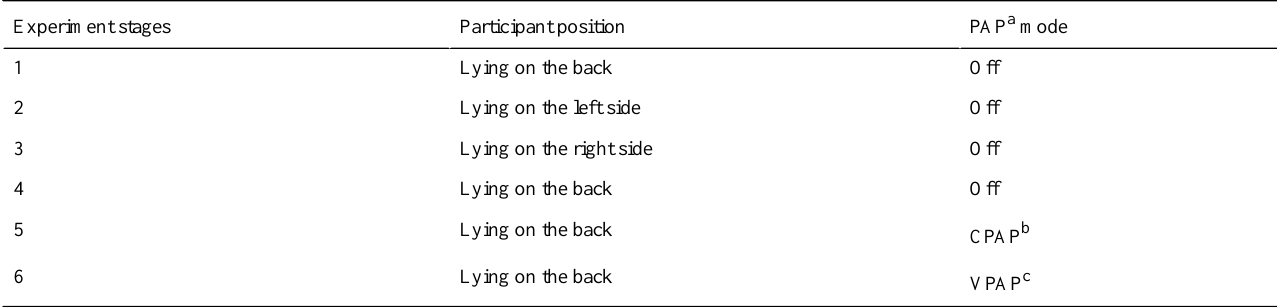
Table 1. Participants’positions and positive airway pressure therapy modes for the experiment. Each experiment stage lasted for 5 minutes.